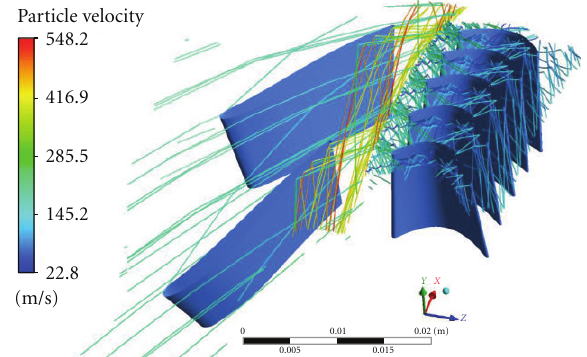
Figure 16: Sample particle trajectories including radial projection for particles seeding within 5% of stator blade span near the hub and shroud at 50% of the gas velocity in the NASA-designed turbine.